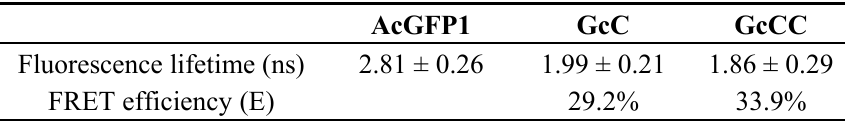
Table 1. Average fluorescence lifetime of AcGFP1 from 293 T cells expressing AcGFP1, GcC, and